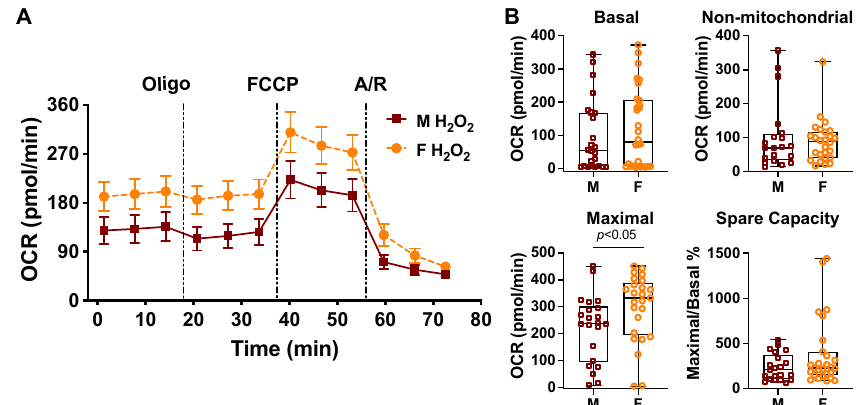
Figure 4. Sex differences in H 2 O 2 -altered bioenergetic response in cardiomyocytes isolated from male and female mice. ( A ) The OCR trace in cardiomyocytes from male (M) and female (F) mice following H 2 O 2 (50 μ M, 1 h) treatment. ( B ). Quantification of basal OCR, non-mitochondrial OCR, maximal rate, and spare respiratory capacity in cardiomyocytes from M and F mice subjected to H 2 O 2 . Data are analyzed using the Mann–Whitney test in B and represented as box and whiskers plots. The results were from four mouse hearts of each sex in four trials.